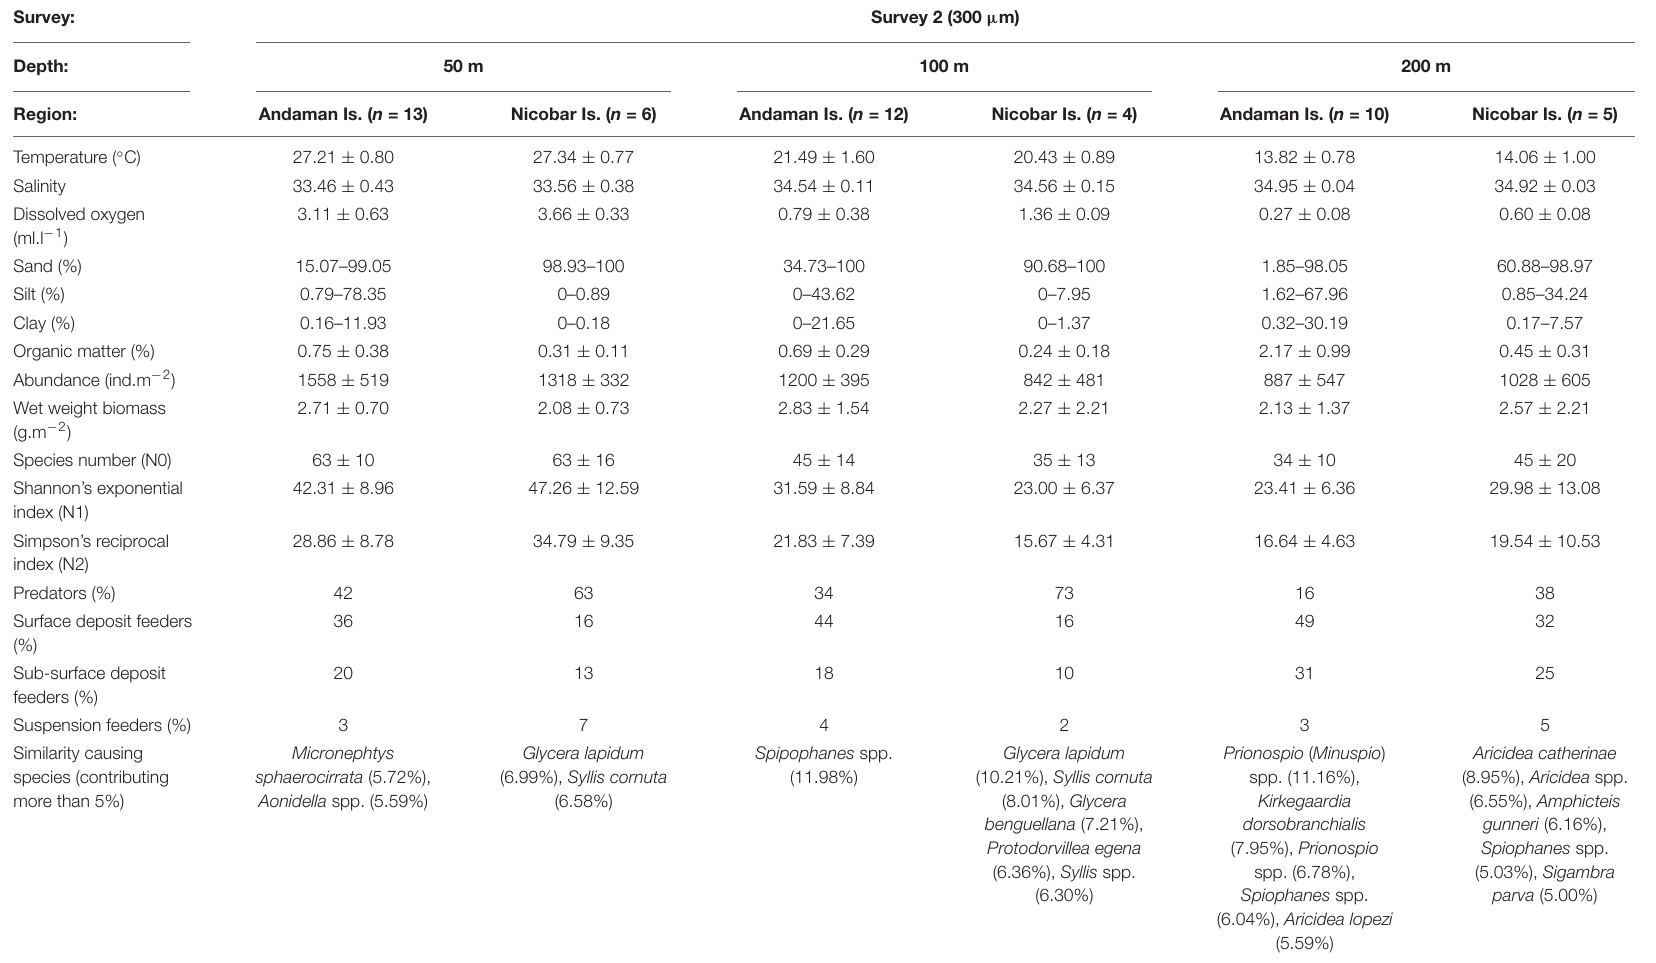
TABLE 4B | Biological characteristics of the polychaete species assemblages in Survey 2 (300 µ m) with prevailing environmental conditions [mean ± SD, n = No. of samples].